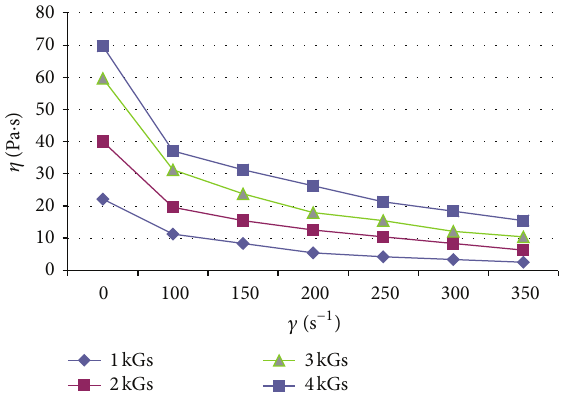
Figure 11: The relationship between viscosity and shear stress rate.